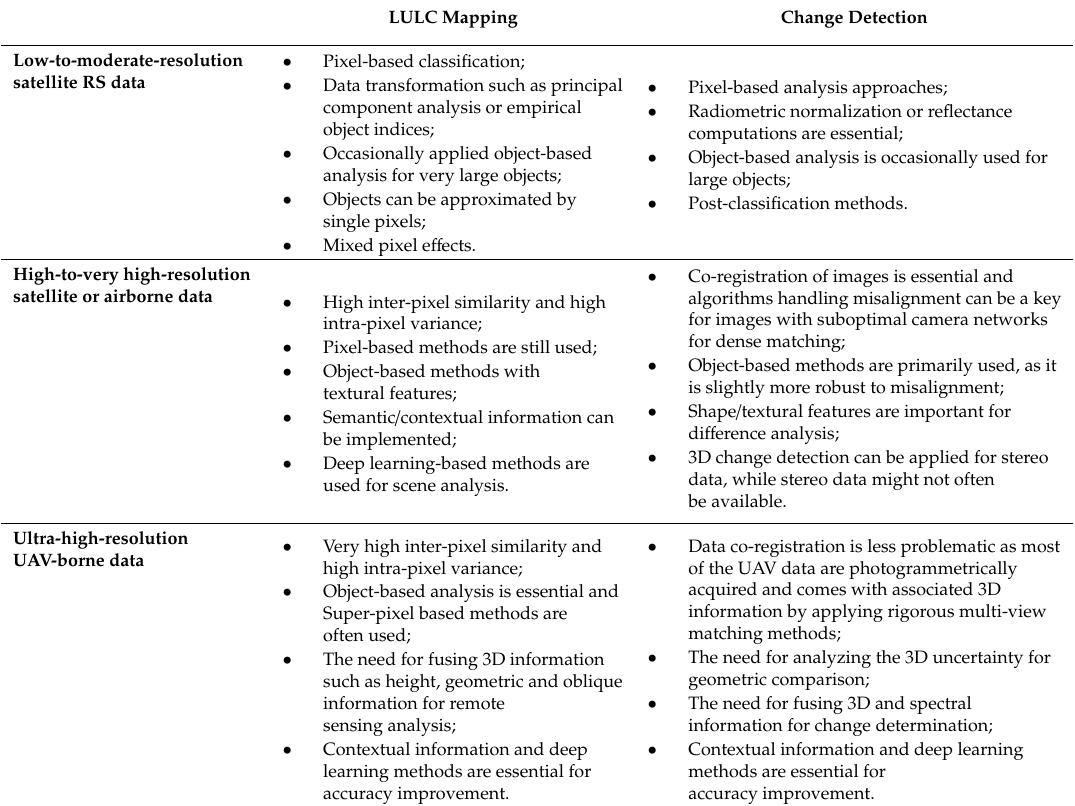
Table 2. Algorithmic considerations for data acquired using di ff erent remote sensing